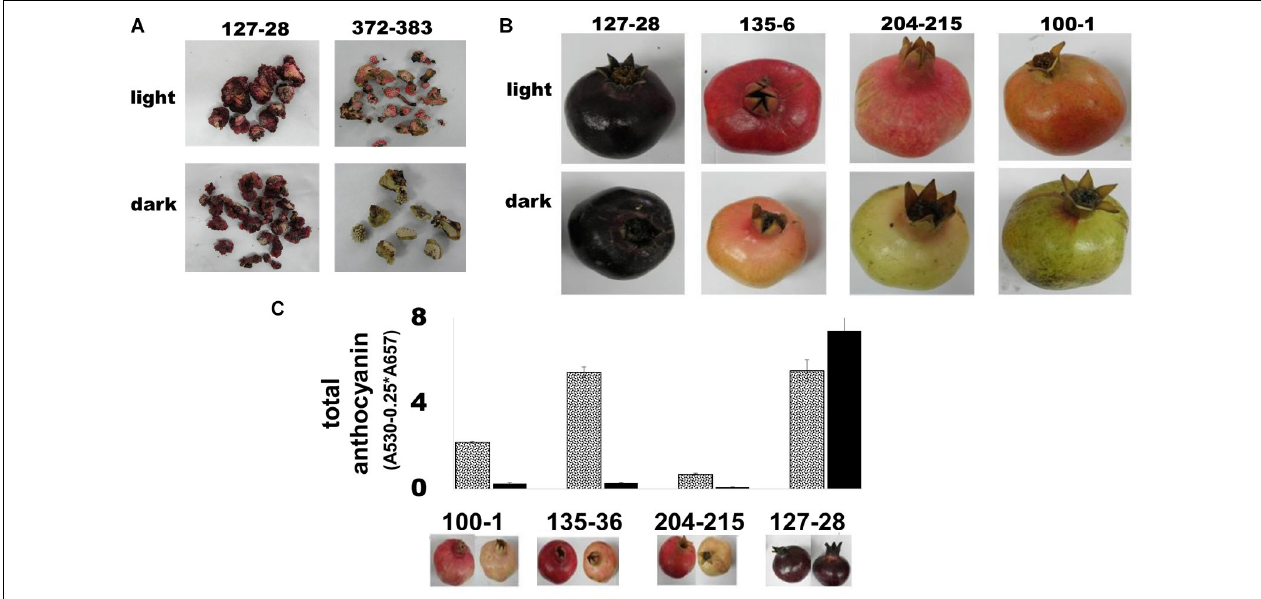
FIGURE 4 | Color accumulation in fruit and tissue culture of the ‘Black’ pomegranate in the absence of light. (A) Light influence on color development in calli derived from the ovary mesocarp of flowers from the ‘Black’ pomegranate and the “red” variety P.G.372-383. The calli were photographed after 2 weeks in complete darkness (B) Light influence on peel color in intact fruit. Fruits at stage 6 were covered with aluminum bags, which prevented any exposure to light. At ripening, covered fruits were compared to uncovered fruits. The figure shows three representative “red” varieties in addition to the ‘Black’ pomegranate. (C) Total amount of anthocyanin in the peel of fully ripe fruit grown in the dark (full black column) was compared with that of control uncovered fruit exposed to light (gray dotted column). Under each column there is an image that represents the uncovered fruit (left) and covered fruit